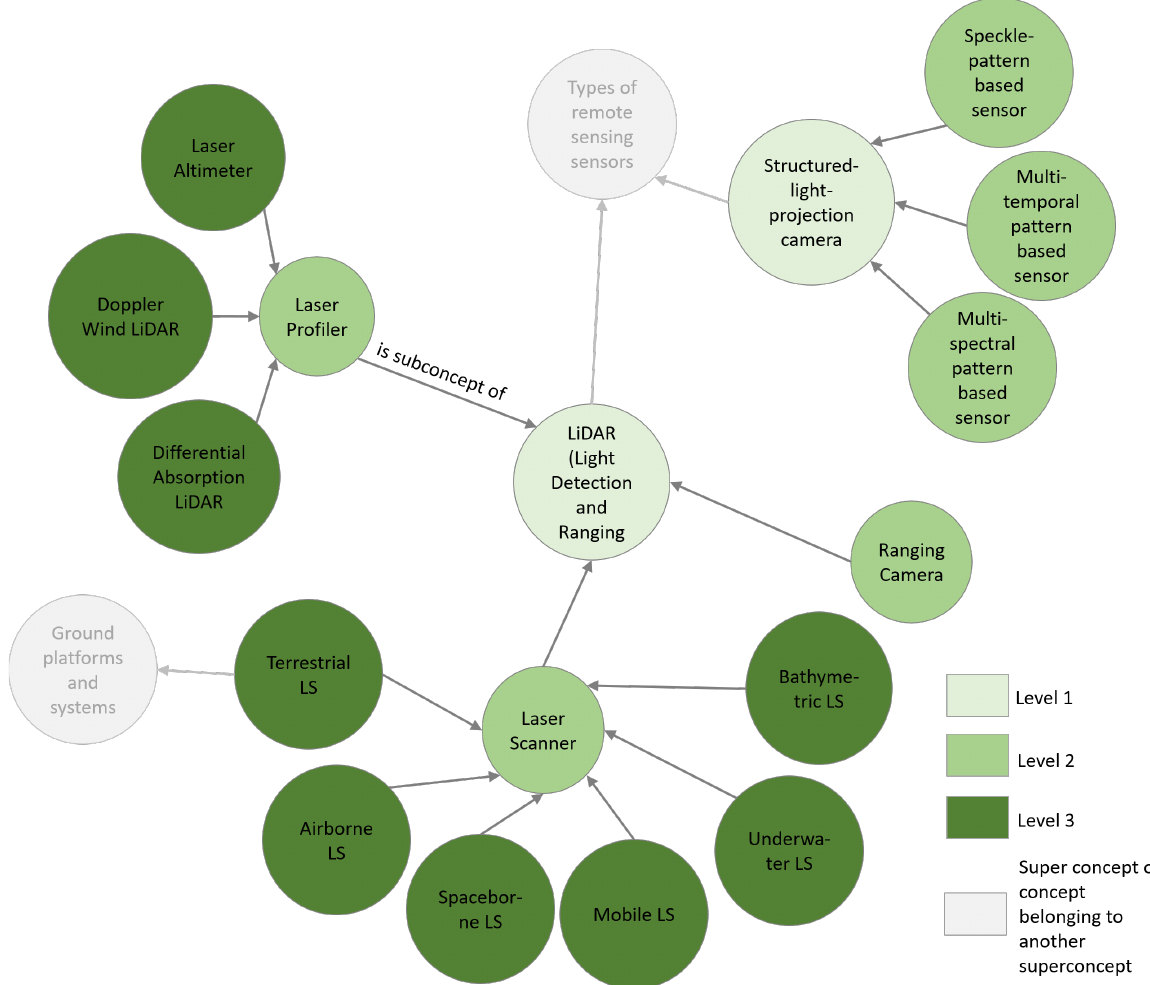
Figure 3 . Schematic representation of the EO4GEO BoK ontology of the active optical